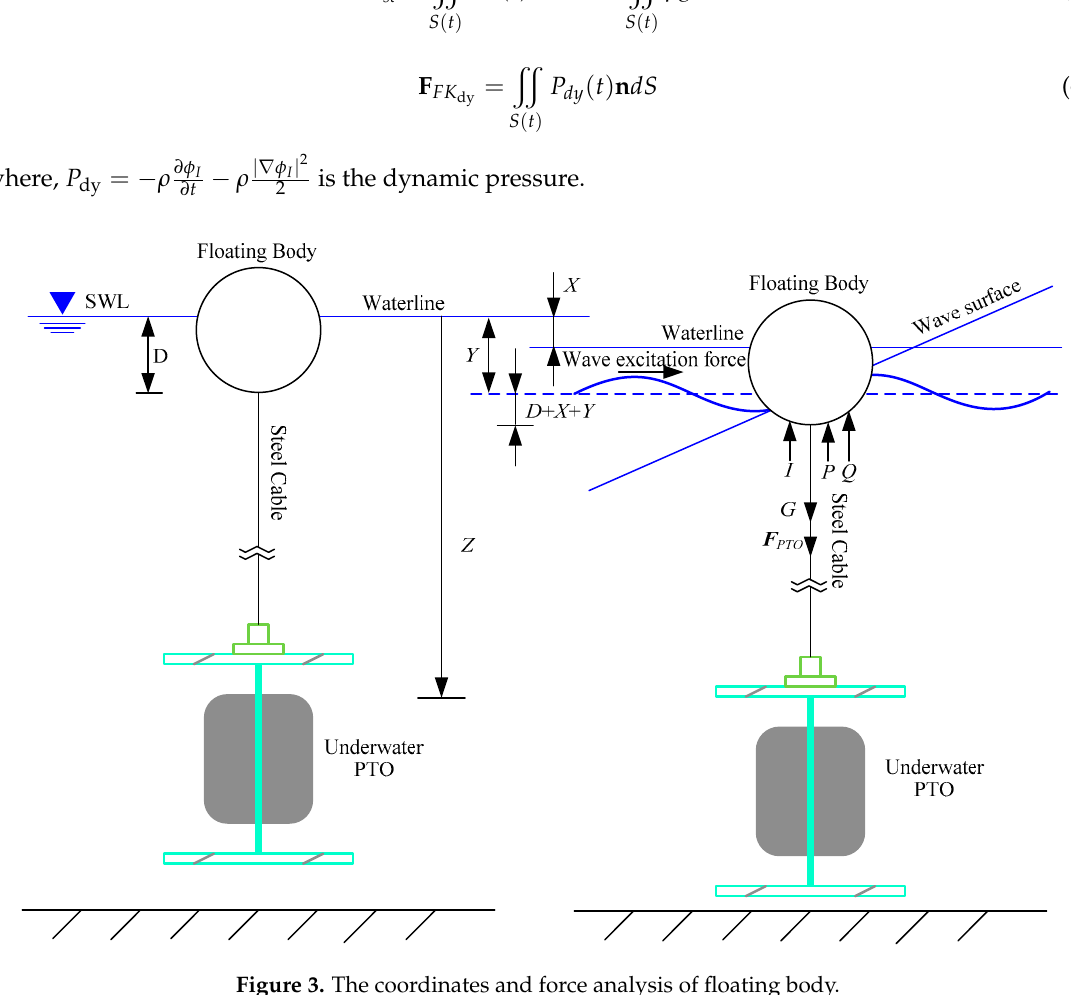
Figure 3. The coordinates and force analysis of floating body.